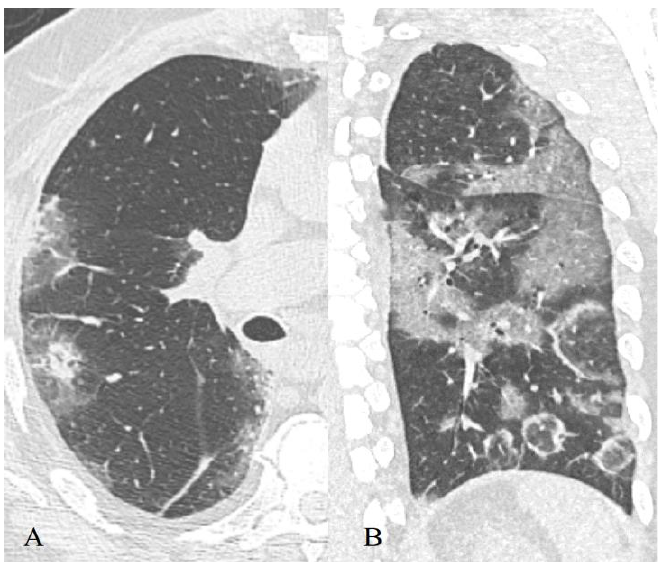
Figure 4. Consolidation types: halo phenomena ( A ) and reverse halo ( B ) with perilobular bands.